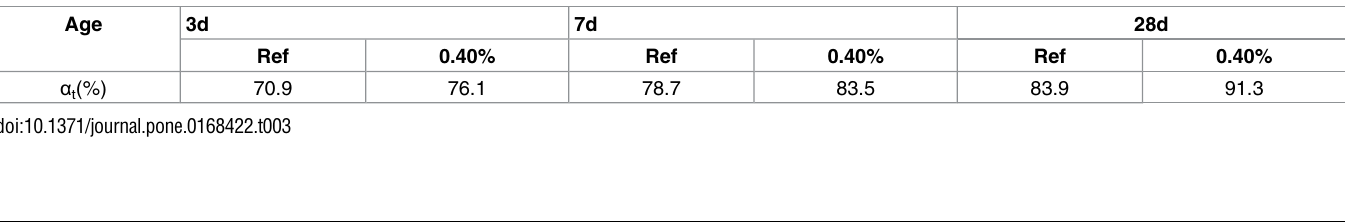
Table 3. Degree of hydration of cement pastes at different aging